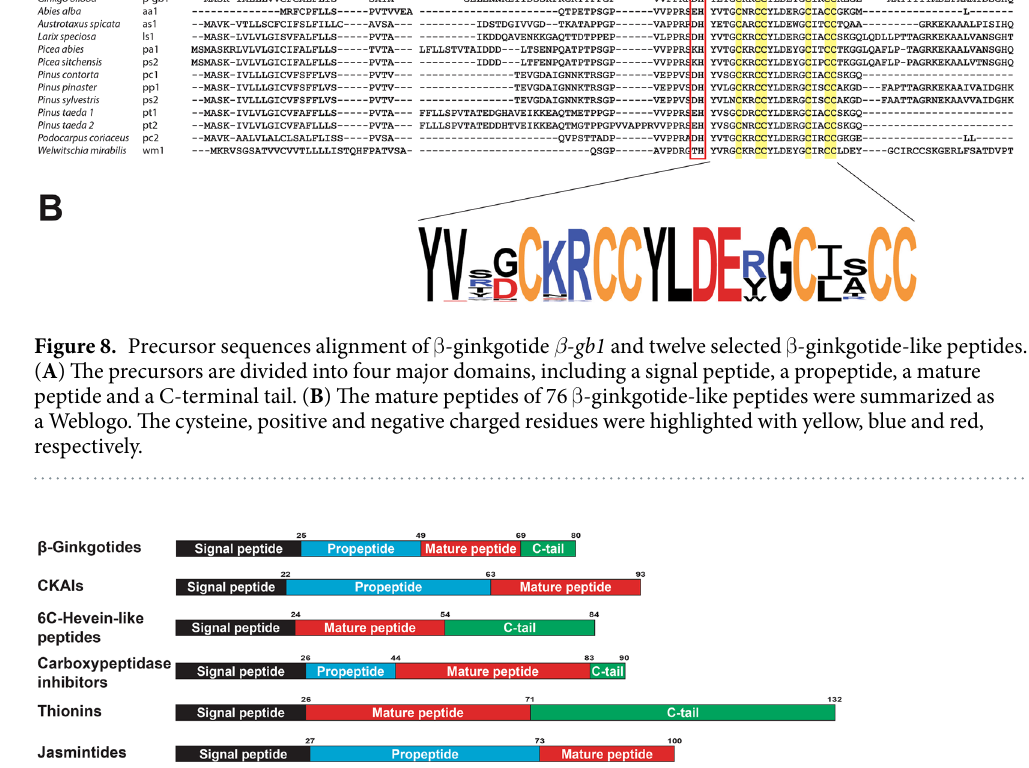
Figure 9. Summary of precursor sequences of β -gB1-like peptides and other known CRPs with six cysteine residues. The number on top of each domain represents the average number of amino